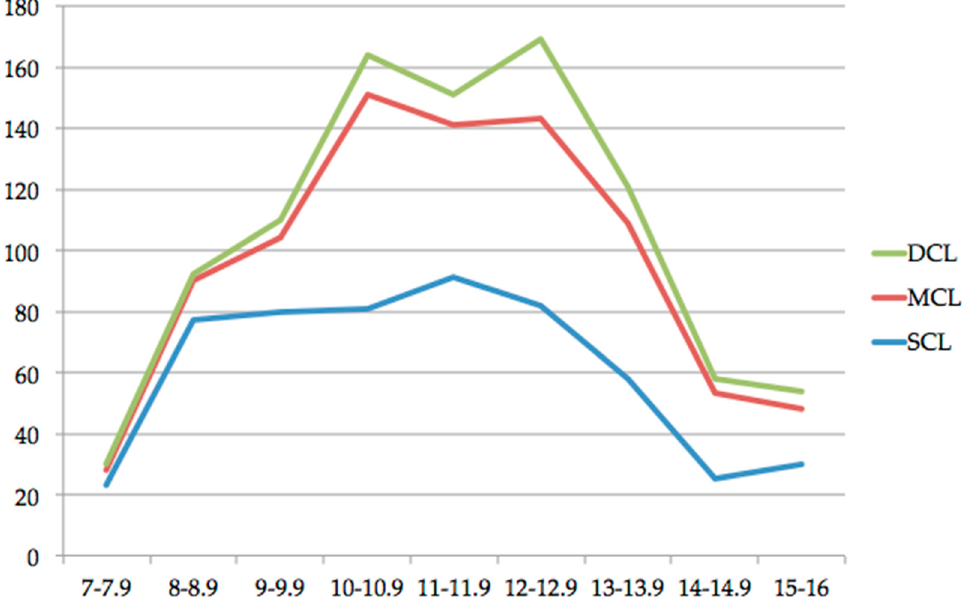
Figure 4. Distribution of superficial carious lesions (SCL), medium carious lesions (MCL), and deep carious lesions (DCL) according to the chronological age of the patients (expressed in years).